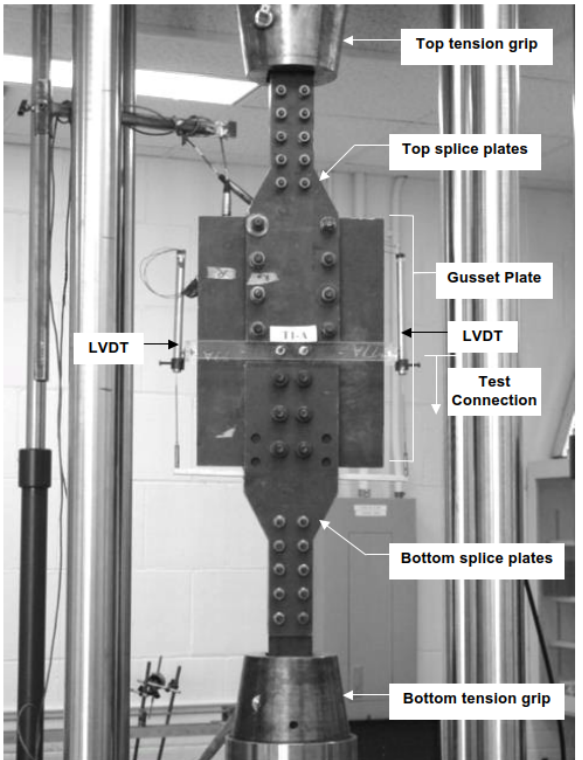
Figure 4. Test set-up for gusset plate connection [7].